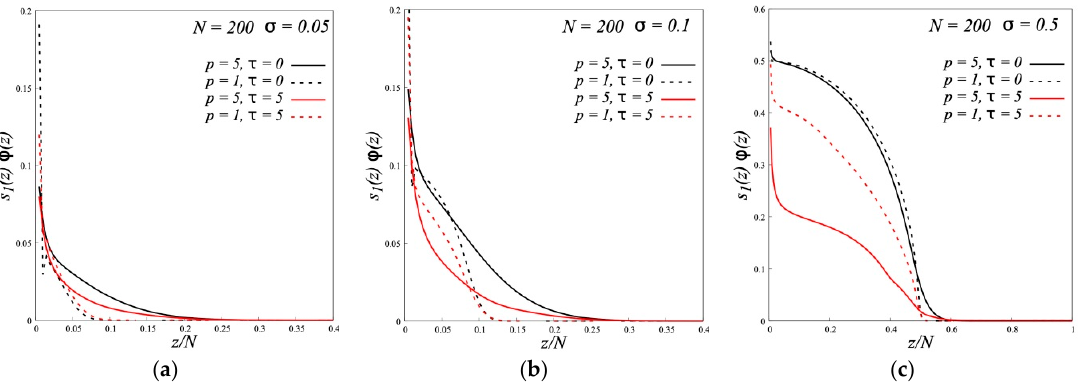
Figure 5. The segment orientation profile s 1 ( z ) ϕ ( z ) = ϕ ( z , +1) − ϕ ( z , − 1) in polymer brushes with different stiffness of the grafted chains ( p ) and different values of the parameter of dipole-dipole interactions ( τ ) at grafting densities σ = 0.05 ( a ), σ = 0.1 ( b ) and σ = 0.5 ( c ).